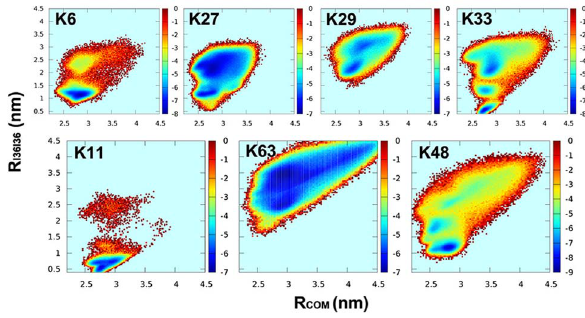
Figure 7. Functional landscapes of K6-, K27-, K29- and K33- diUbs. Upper subfigures are the free energy profiles of K6, K27, K29 and K33 linked diUbs plotted as a function of R COM and R I 36 I 36 . Lower subfigures are the free energy profiles of K11, K63 and K48 linkages, shown as references. They represent compact, open and the multi-state functional landscapes,